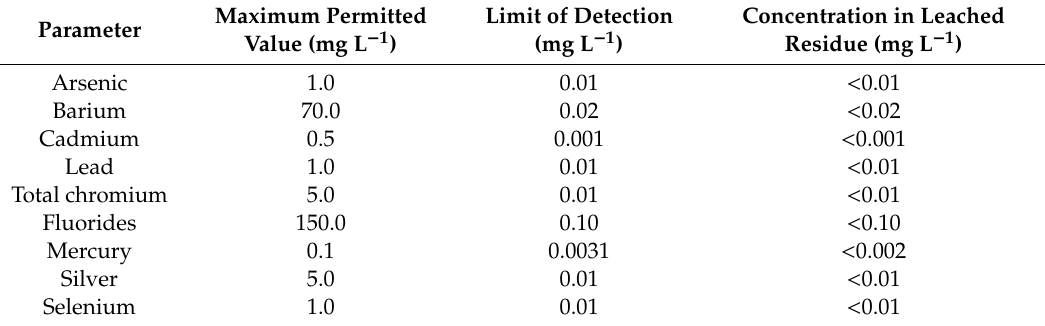
Table 1. Classification of leached residue toxicity for inorganic parameters according to the Standard Methods for Examination of Water and Wastewater, 20th ed. [9], including maximum permitted value, limit of detection and the concentration of leached residue in the leached residue.